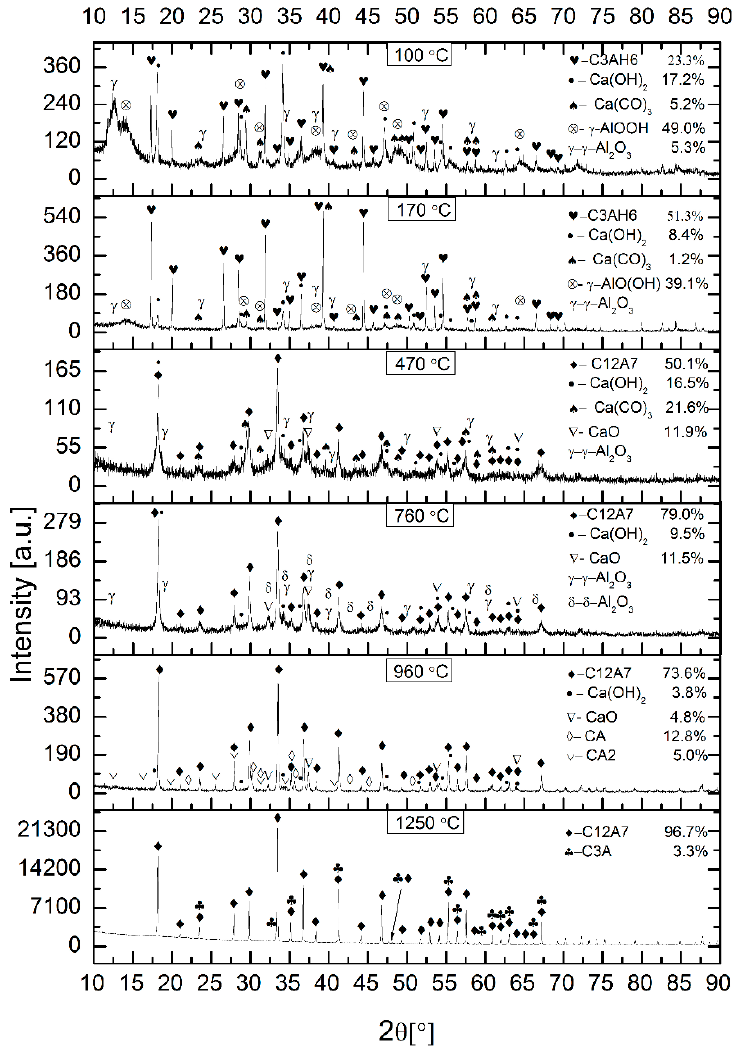
Figure 2. XRD patterns of powders calcined at different temperatures; phase names are indicated together with their weight contents.